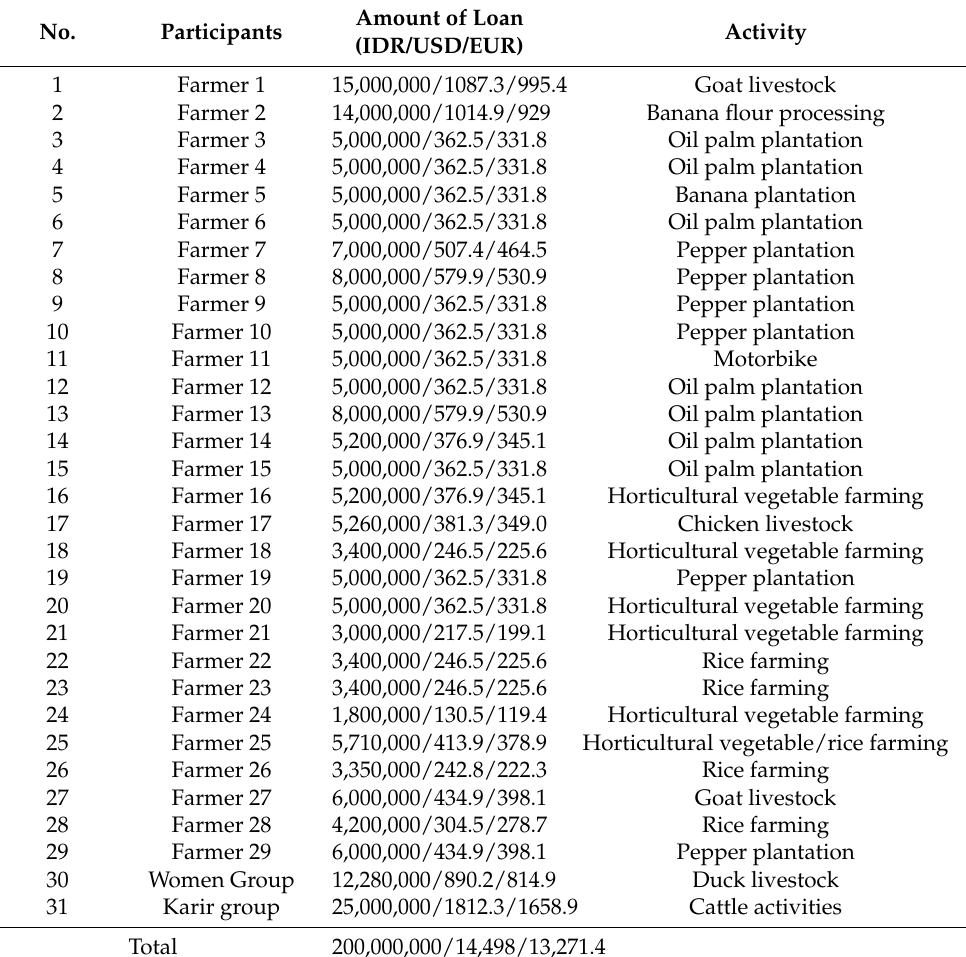
Table 4. Loan distribution among the Karir group 2015–2016 (2015 rates USD 1 = IDR 13,795 and